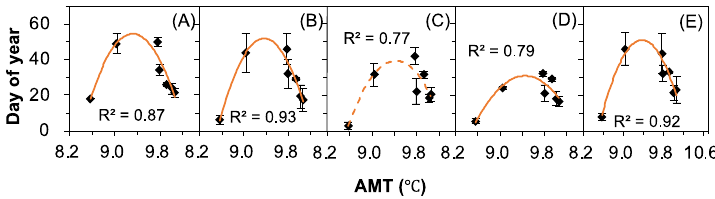
Figure 7. Correlations between the onset ( A – E ), peak ( F – J ), and end ( H – L ) of the fruit ripening events and the onset of seed release (OSR) of Nitraria tangutorum . The solid lines indicate p ≤ 0.05. OFR, PFR, and EFR represent the onset, peak, and end of the fruit ripening period, respectively.